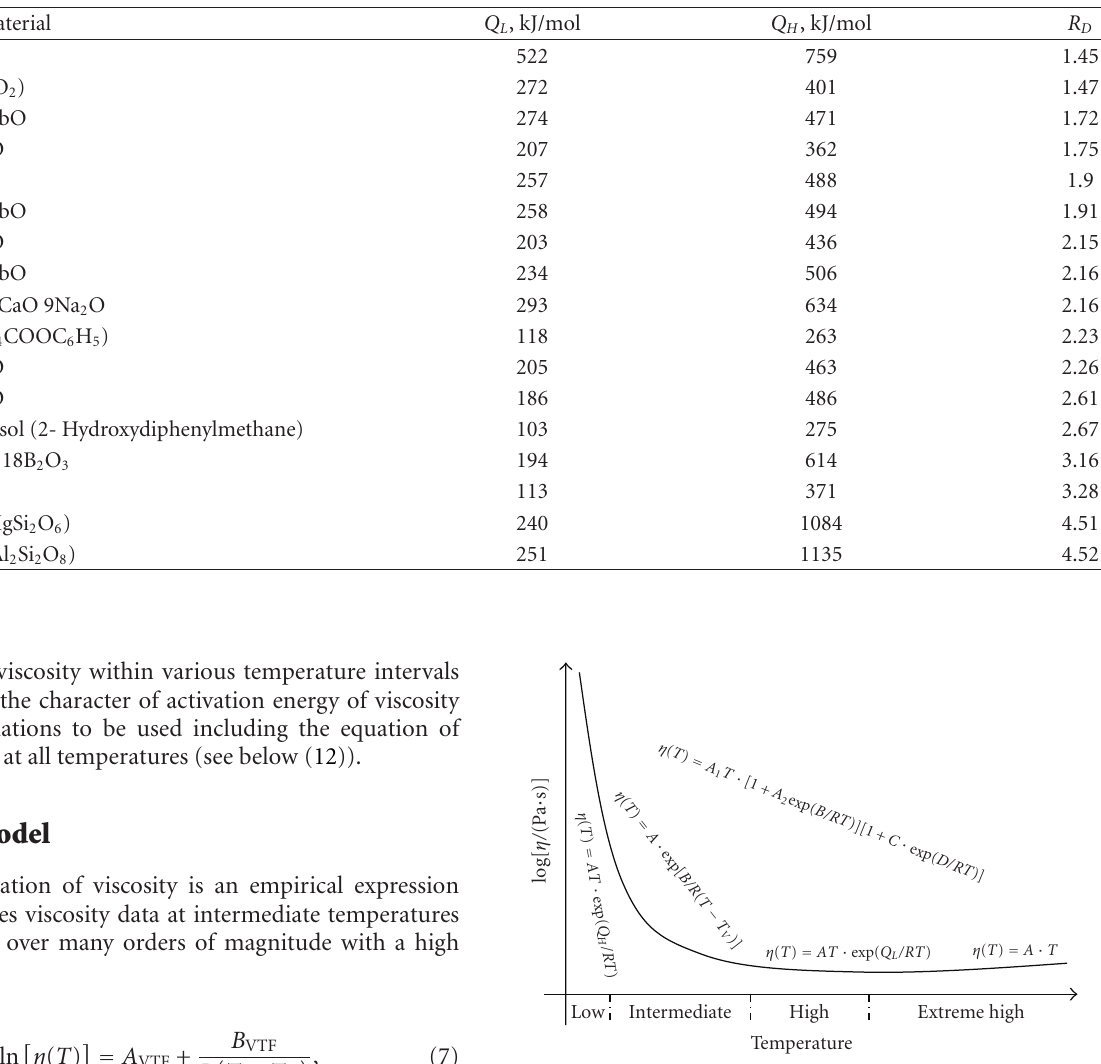
Figure 6: Temperature behaviour of viscosity of amorphous materials as described by the universal equation (12). The activation energy of viscous flow is constant and high at low temperatures, it is variable at intermediate temperatures, and it is constant and low at high temperatures. At extreme high temperatures, the flow becomes